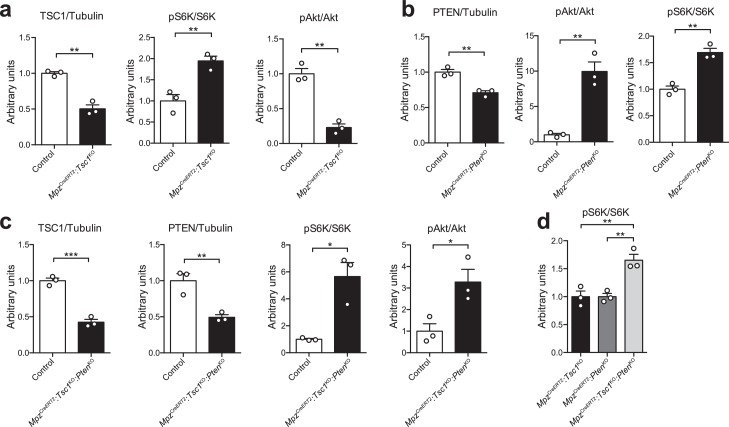
Quantification of western blots.Bar height: mean; error bars: s.e.m. (a) Quantification referring to Figure 5a. Control average is set to 1 (n = 3 mice/genotype, including the biological replicates representatively shown in Figure 5a, two-tailed unpaired Student’s t-test; TSC1/Tubulin, t(4) = 8.457, p=0.0011; pS6K/S6K, t(4) = 5.062, p=0.0072; pAkt/Akt, t(4) = 8.401, p=0.0011). (b) Quantification referring to Figure 5b. Control average is set to 1 (n = 3 mice/genotype, including the biological replicates representatively shown in Figure 5b, two-tailed unpaired Student’s t-test; PTEN/Tubulin, t(4) = 6.185, p=0.0035; pAkt/Akt, t(4) = 6.662, p=0.0026; pS6K/S6K, t(4) = 6.837, p=0.0024). (c) Quantification referring to Figure 5c. Control average is set to 1 (n = 3 mice/genotype, including the biological replicates representatively shown in Figure 5c, two-tailed unpaired Student’s t-test; TSC1/Tubulin, t(4) = 10.76, p=0.0004; PTEN/Tubulin, t(4) = 4.879, p=0.0082; pS6K/S6K, t(4) = 4.477, p=0.011; pAkt/Akt, t(4) = 3.353, p=0.0285). (d) Quantification referring to Figure 5d. MpzCreERT2:Tsc1KO average is set to 1 (n = 3 mice/genotype, including the biological replicates representatively shown in Figure 5d, one-way ANOVA with Tukey’s multiple comparisons test, F(2,6) = 17.6, p=0.0031; pTSC1KO vs doubleKO = 0.0051, pPTENKO vs doubleKO = 0.0051). *p<0.05, **p<0.01, ***p<0.001.